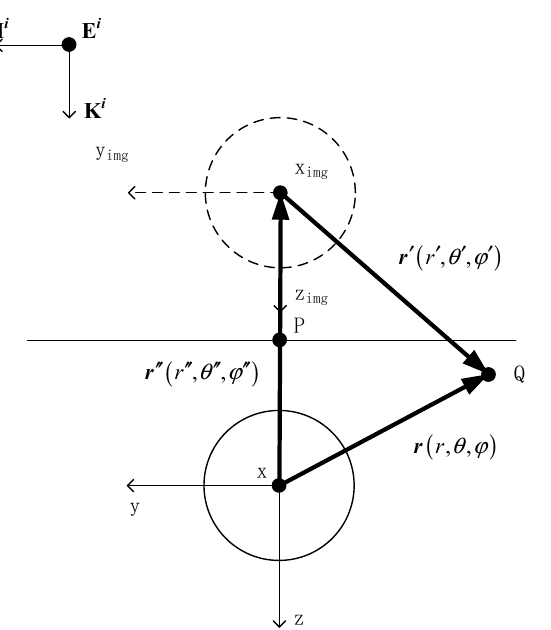
Figure 2. Relationship between r , r (cid:48) , r (cid:48)(cid:48) in the global coordinate system and local coordinate tem.